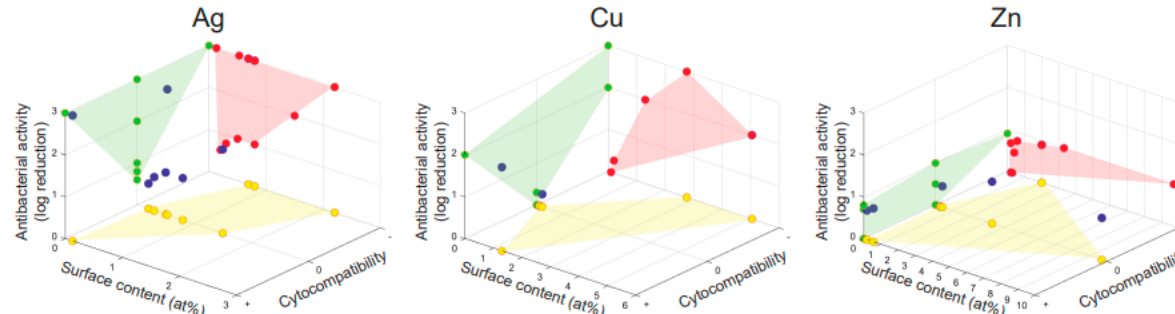
Figure 5. The relation between the antibacterial activity, cytocompatibility, and surface content for titanium surfaces biofunctionalized by PEO with Ag, Cu, or Zn. The reported antibacterial activity as a function of surface content and cytocompatibility is depicted by the blue dots. The green, red, and yellow projections enable a comparison between the parameters. Cytocompatibility is depicted as cytotoxicity ( − ), no effect (0), or enhanced cytocompatibility (+).